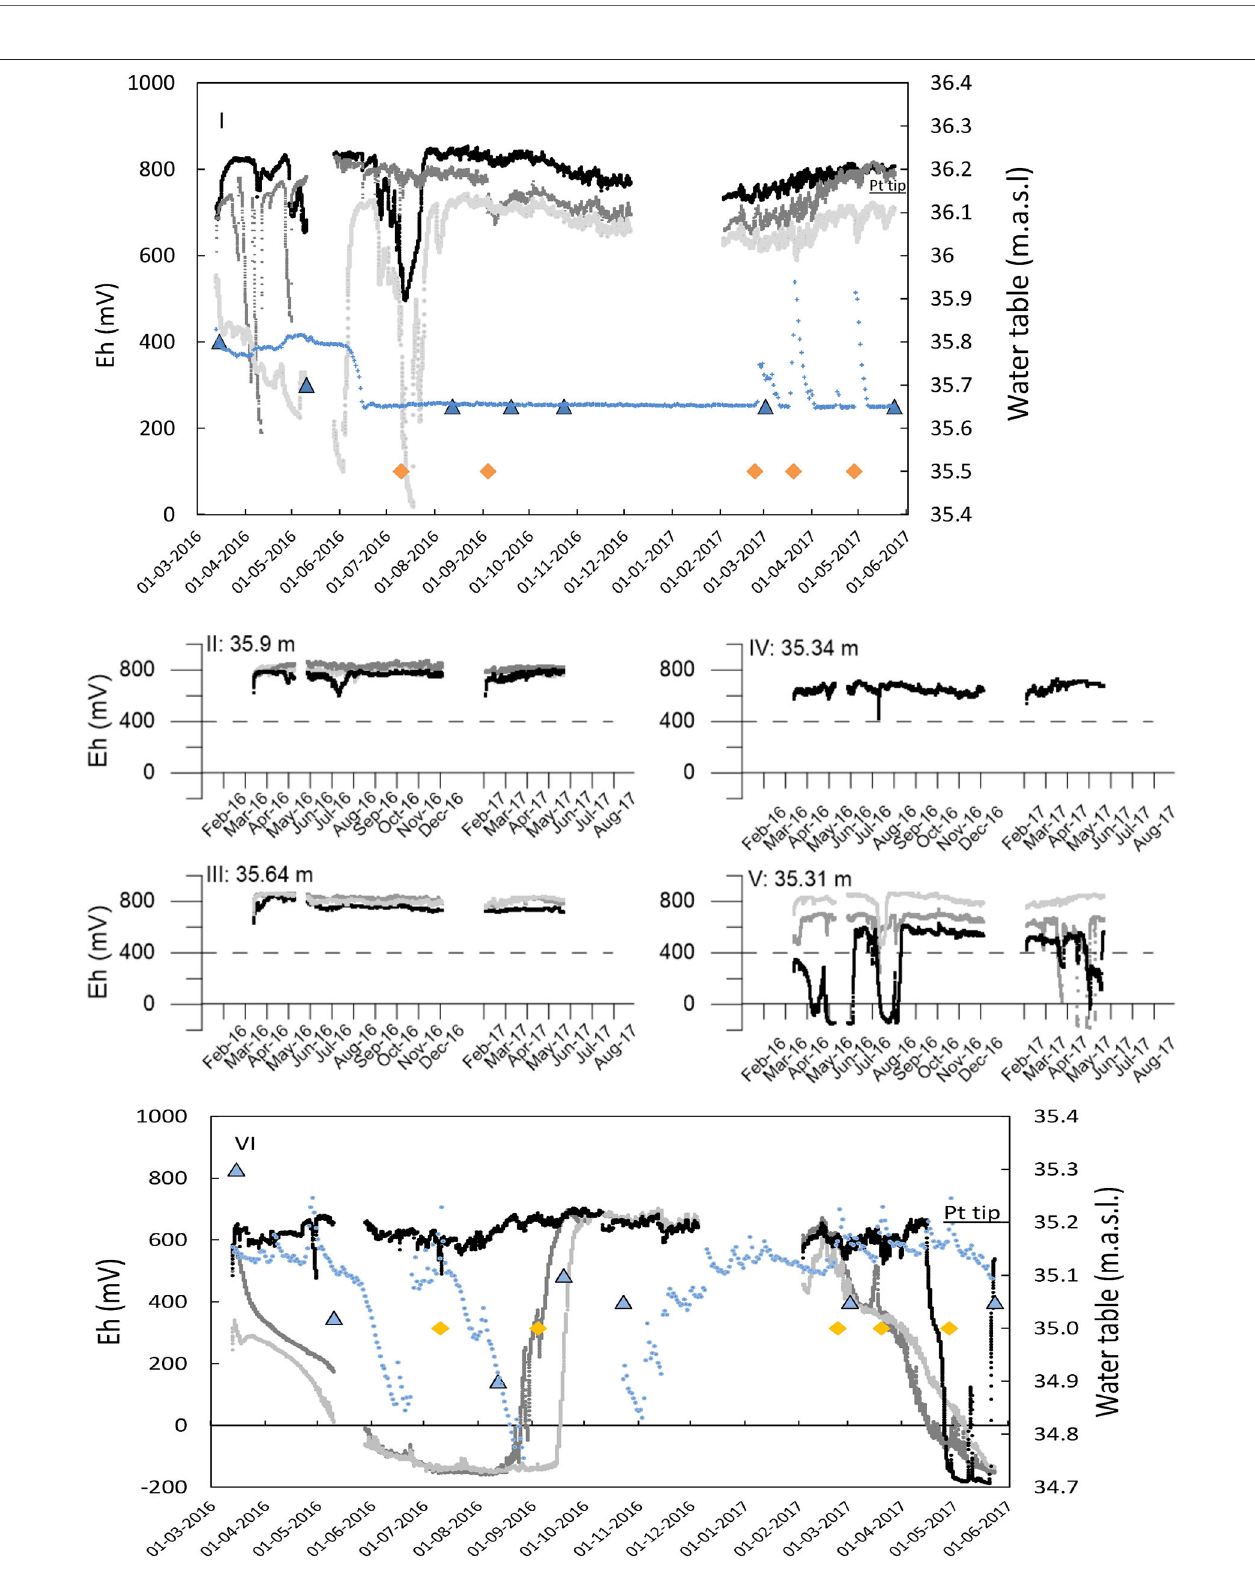
FIGURE 5 | Eh and water table fluctuations during March 2016 to June 2017 at the Eh measurement points in location B adjacent to the water loggers. I: Upslope position 36.4m a.s.l.; II–V. Pt group positions on the slope; VI low area near ditch 35.4m a.s.l. The top end of axis2 (water table) indicate the soil surface. Pt tip marked on axis2 shows the platinum sensor position, m a.s.l. The black and the two gray lines indicate the triplicate Eh measurements, mV, vs. date (axis 1). Yellow diamonds: 20 + mm rain events (marks the date on x-axis). Blue dots (axis 2): Water table by Hobo U20 logger and manual water level measurement (blue triangles – dry from July 16 to March 17) and short periods